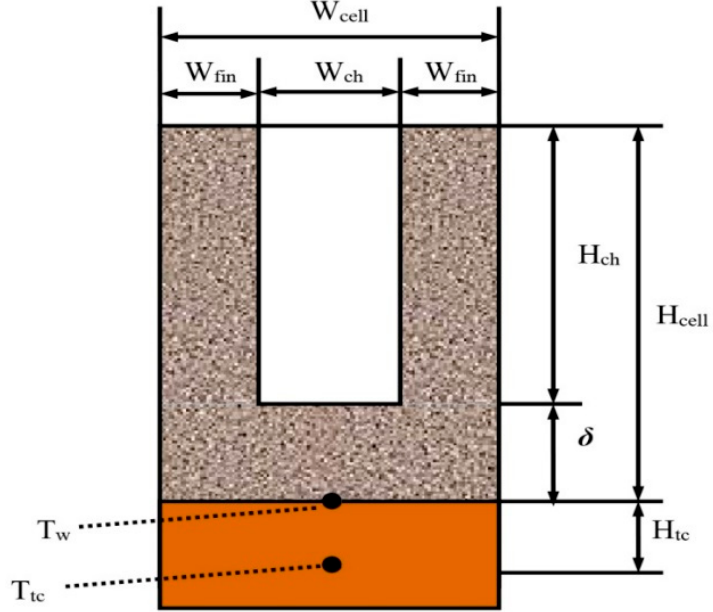
Figure 3. Structural parameters of porous microchannel unit cell.